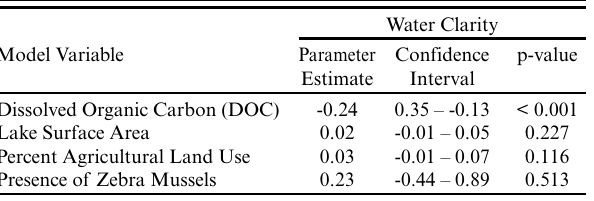
Table 3 . Parameter estimates from the top biophysical model (as identified using AICc) predicting water clarity (Secchi disc depth) in the Rideau Valley, Ontario, between 2001 and 2013.